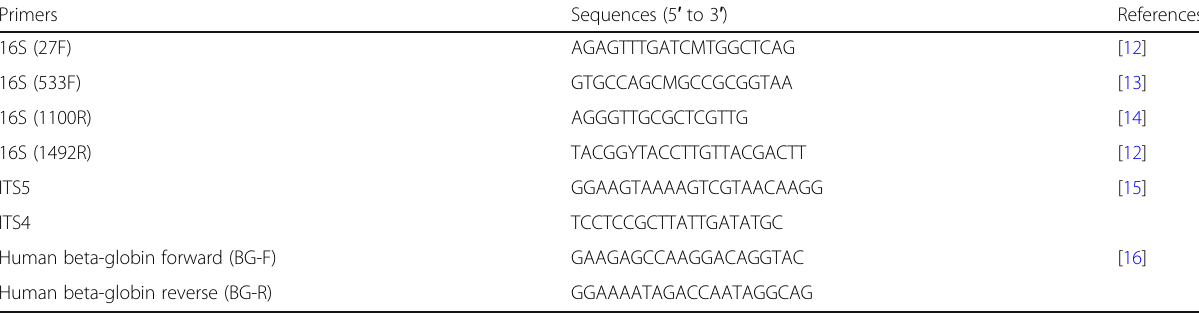
Table 2 PCR primers for bacterial 16S, fungal ITS and human beta-globin PCR Primers